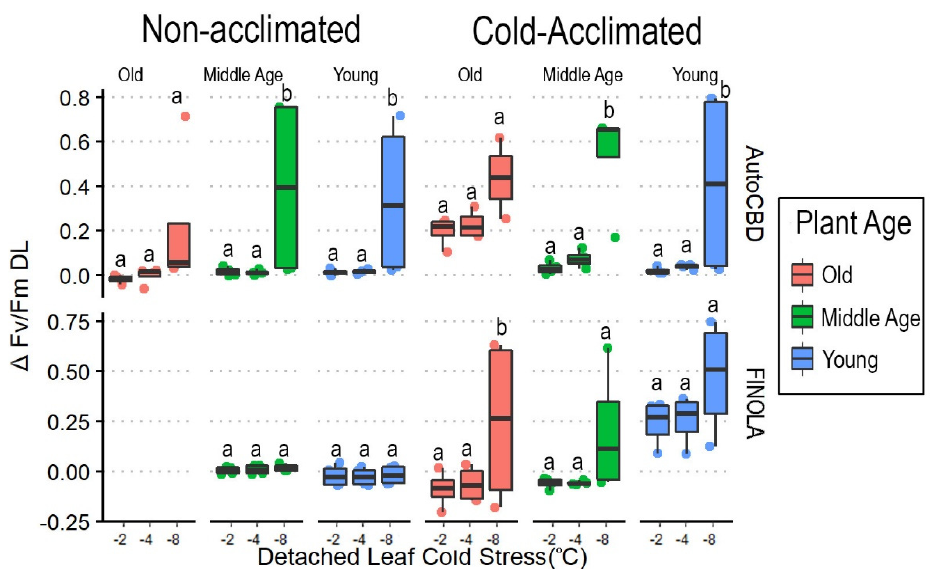
Figure 4. Δ Fv/Fm DL box plots comparing detached-leaf cold stress and plant age in cold-acclimated and non-acclimated ‘AutoCBD’ and ‘FINOLA’ plants. Data represent the difference between Fv/Fm taken before whole-plant cold stress and after detached-leaf cold stress. Non-acclimated plants received no cold acclimation period, and cold-acclimated plants were subject to 10 days at 10 °C. Detached-leaf cold stress consisted of a single 3 h − 2 °C exposure, a single 3 h − 4 °C exposure, and a single 3 h − 8 °C exposure. Plant age treatments include oldest plants, middle-age plants, and youngest plants (68, 54, and 40 days old on the day of whole-plant cold stress, respectively). Y axis scale differs between acclimation treatments to accurately reflect data. Lowercase letters indicate significant differences ( p < 0.05) between treatments (Tukey’s test). Detached-leaf SPAD readings were affected by cultivar ( F = 34.410, p < 0.0001), cold acclimation ( F = 16.411, p < 0.001), and detached-leaf cold stress ( F = 10.640, p < 0.0001). Two interactions, cultivar × plant age × detached-leaf cold stress ( F = 5.545, p < 0.001) and cultivar × detached-leaf cold stress ( F = 4.090, p < 0.05), occurred involving the effect of cold temperature intensity on cold tolerance. Letters indicate differences amongst consec- utive cold exposures between cultivars, plant age, and acclimation (Figure 5).